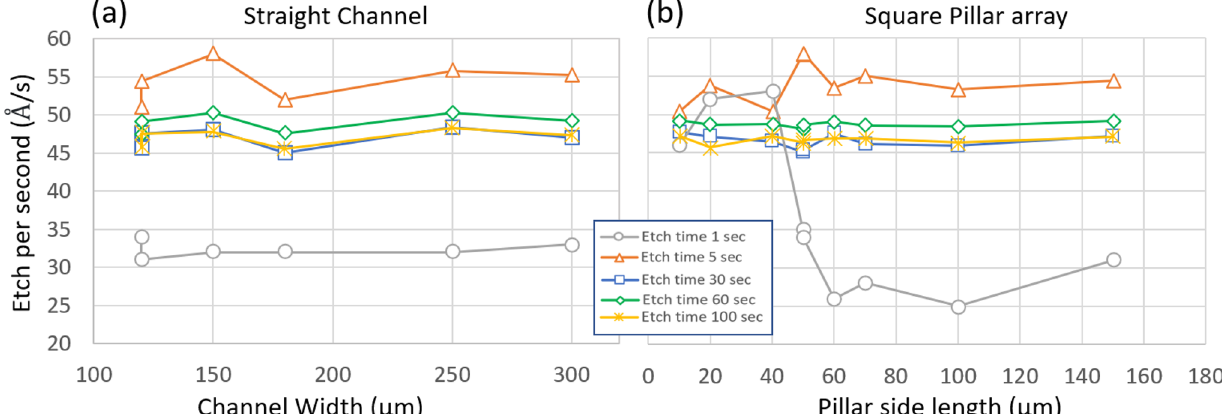
Figure 3. To establish repeatability and standardizability of our method, precise characterization of the oxide etch rate is imperative. The characterization wafer consisting of straight channels and square pillar arrays were etched for varying durations (1–100 s) and the etch per second in Å /s has been plotted as a function of the feature type and dimensions. The raw data used to plot these curves can be found in the Supplementary Information. Etch per second was found to be stable around 5 nm/s. However, the important observation is the fact that no Aspect Ratio Dependent Etching (ARDE) in SiO 2 is noticed (the maximum variation in etch per second in different geometries was found to be ~ 1 nm/s) showing a consistent etch per second value for different feature dimension and loading conditions. Etch per second was seen to be more influenced by total etch time, especially when total etch time is low (≤ 5 s)—this is the result of unpredictable and non-uniform plasma distribution in the etch chamber when etch time is only 1 s. At higher etch times (30 s, 60 s, 100 s) the etch per second showed less variation and were closer to each other (45–50 Å /s) indicating good